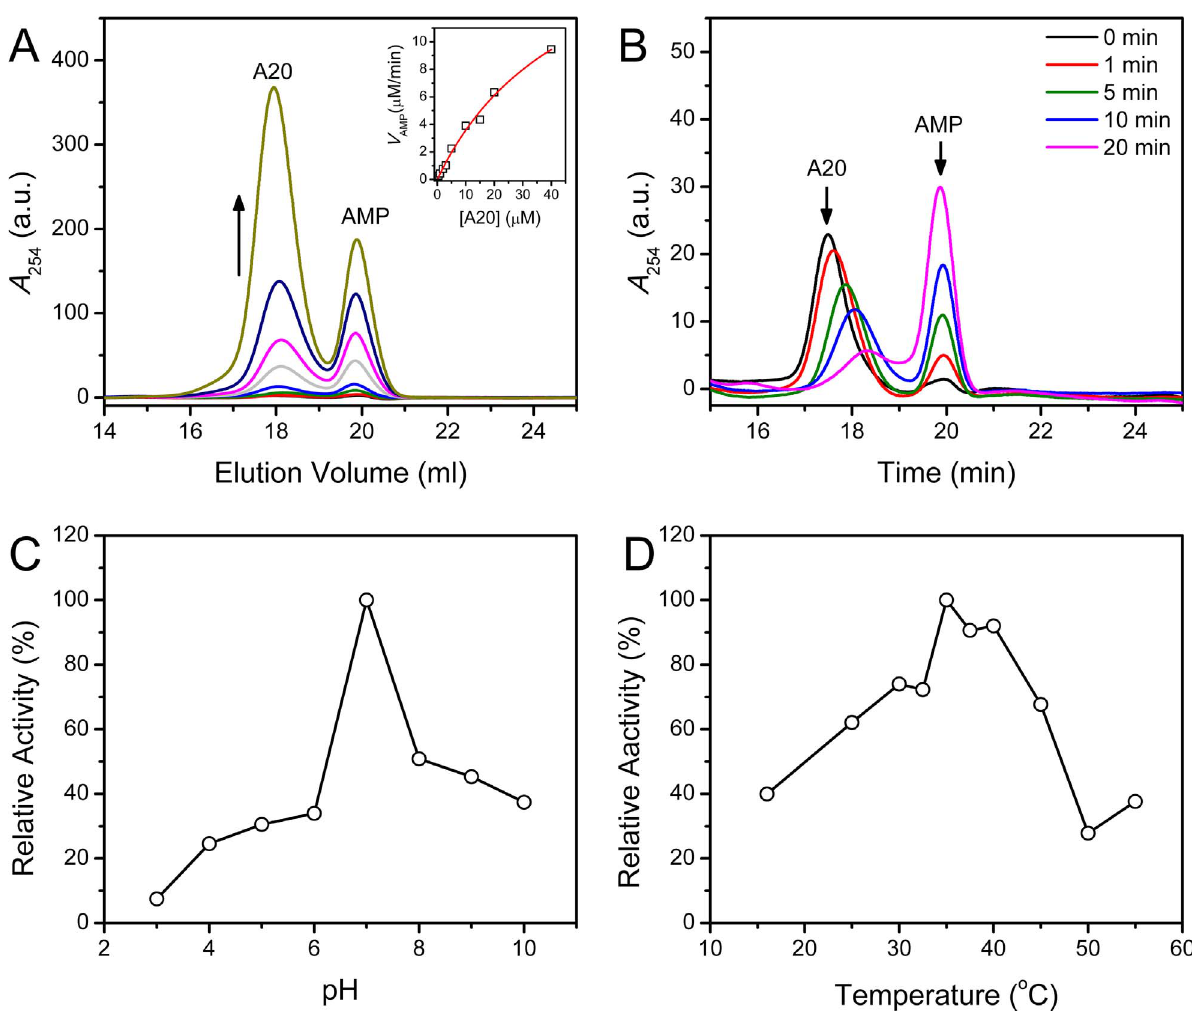
Figure 4. Enzymatic properties of CrCaf1. (A) Determination of the enzymatic parameters by varying the concentration of the substrate A20. The concentration of A20 ranged from 0 to 40 m M, and the concentration of CrCaf1 was 0.05 mg/ml. The reaction time was 10 min. The arrow indicates the direction of increasing the substrate concentration. The inset shows the data fitting using the Michaelis–Menten equation, and the fitted curve is presented as a solid line. (B) Catalytic pattern of CrCaf1 by the SEC method. The SEC profiles were collected at various time intervals. The positions of the substrate A20 and the product AMP are labeled. (C) Characterization of the optimal pH for CrCaf1 reaction. (D) Temperature- dependence of CrCaf1